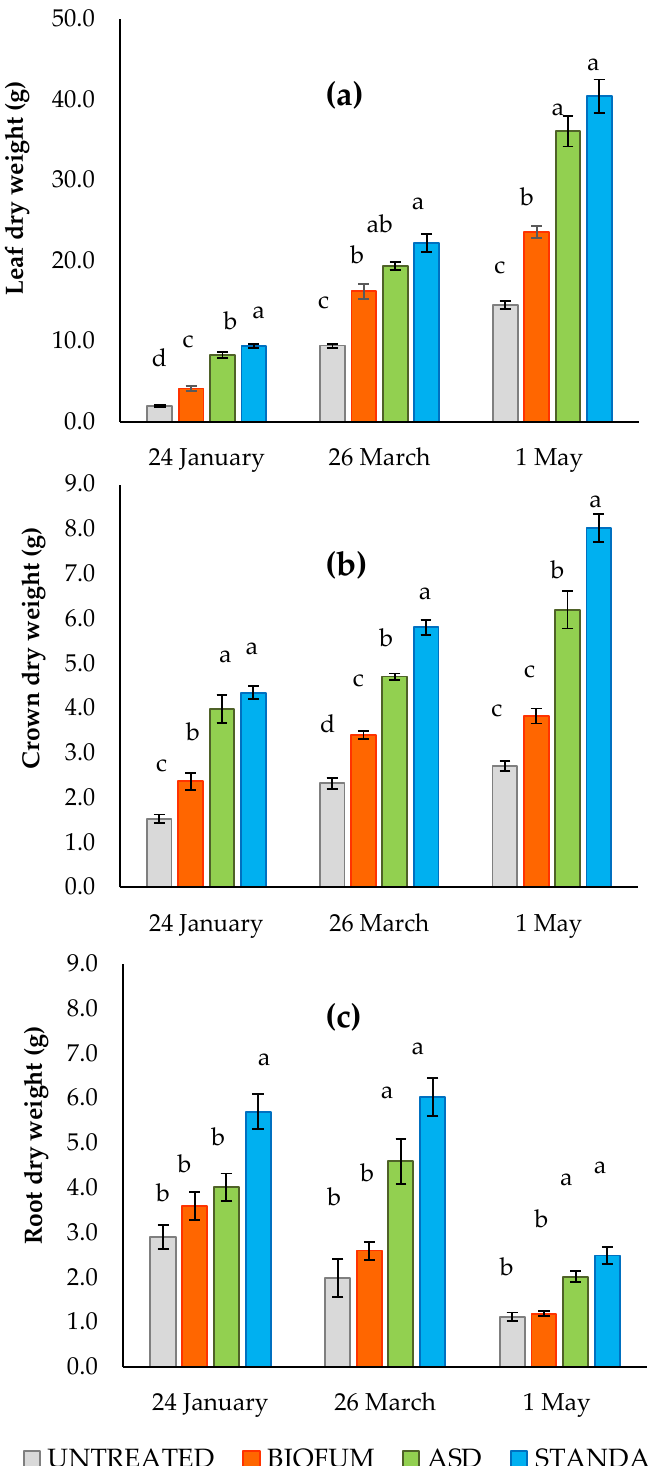
Figure 3. Effect of different soil pre-plant treatments on the leaf ( a ) (top), crown ( b ) (middle), and root ( c ) (below) dry weight of Sabrosa* plants during the 2018/19 cropping season (first year trial). Bars are average ± standard error. Within the same sampling date, bars marked by different letters are significantly different ( p ≤ 0.05, Tukey HSD test).